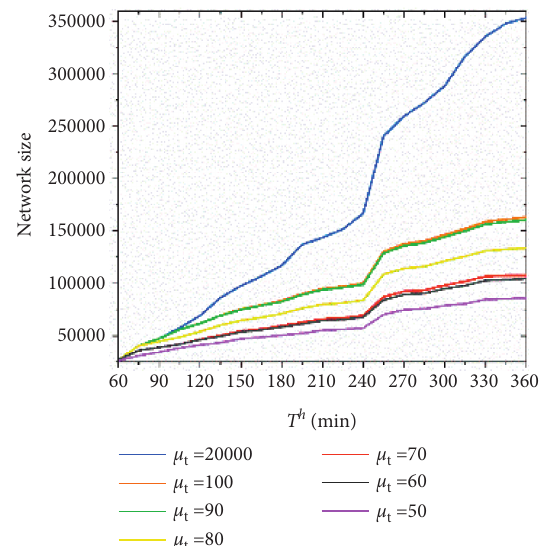
Figure 16: Results of network size with different travel time limits.